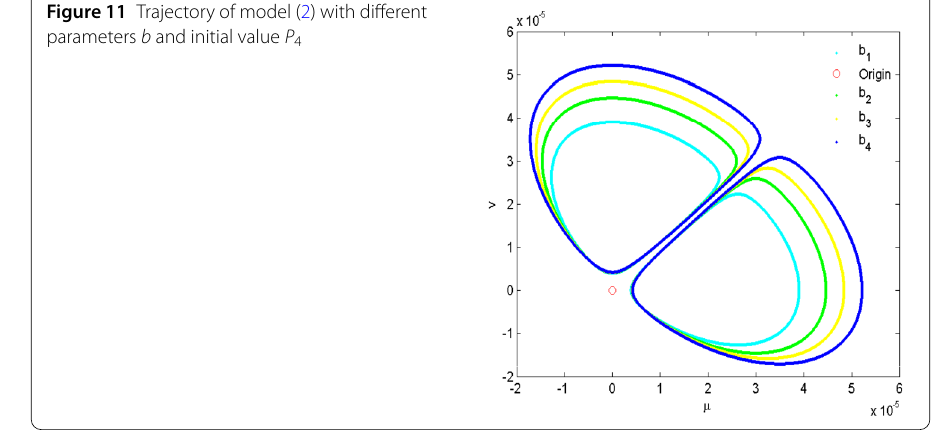
Figure 11 Trajectory of model (2) with different parameters b and initial value P 4